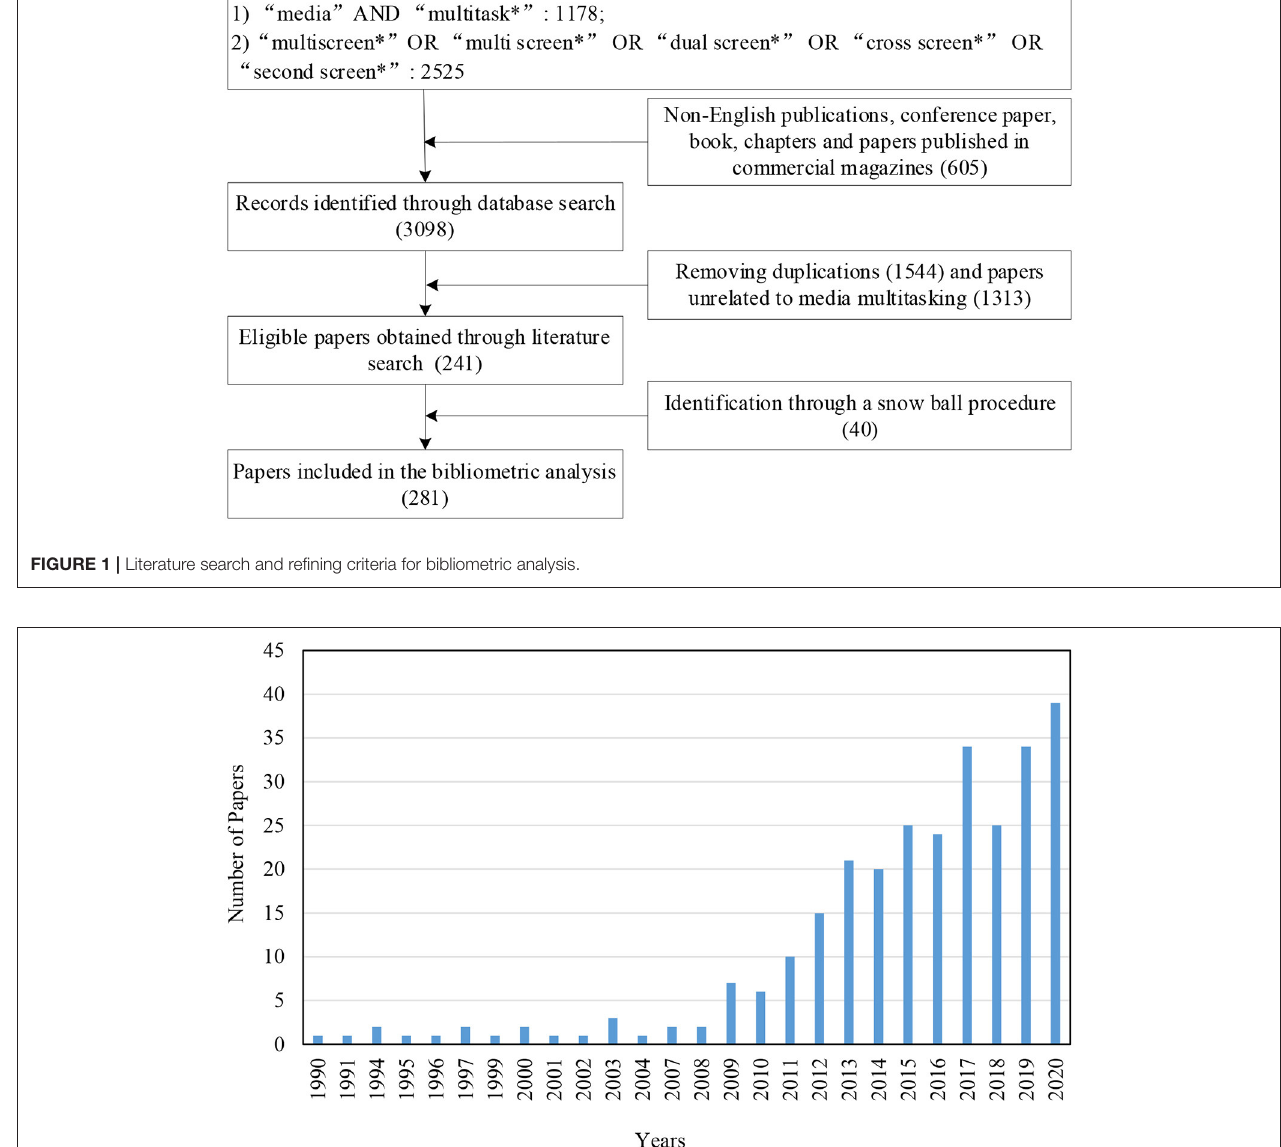
FIGURE 2 | Number of publications on media multitasking over the